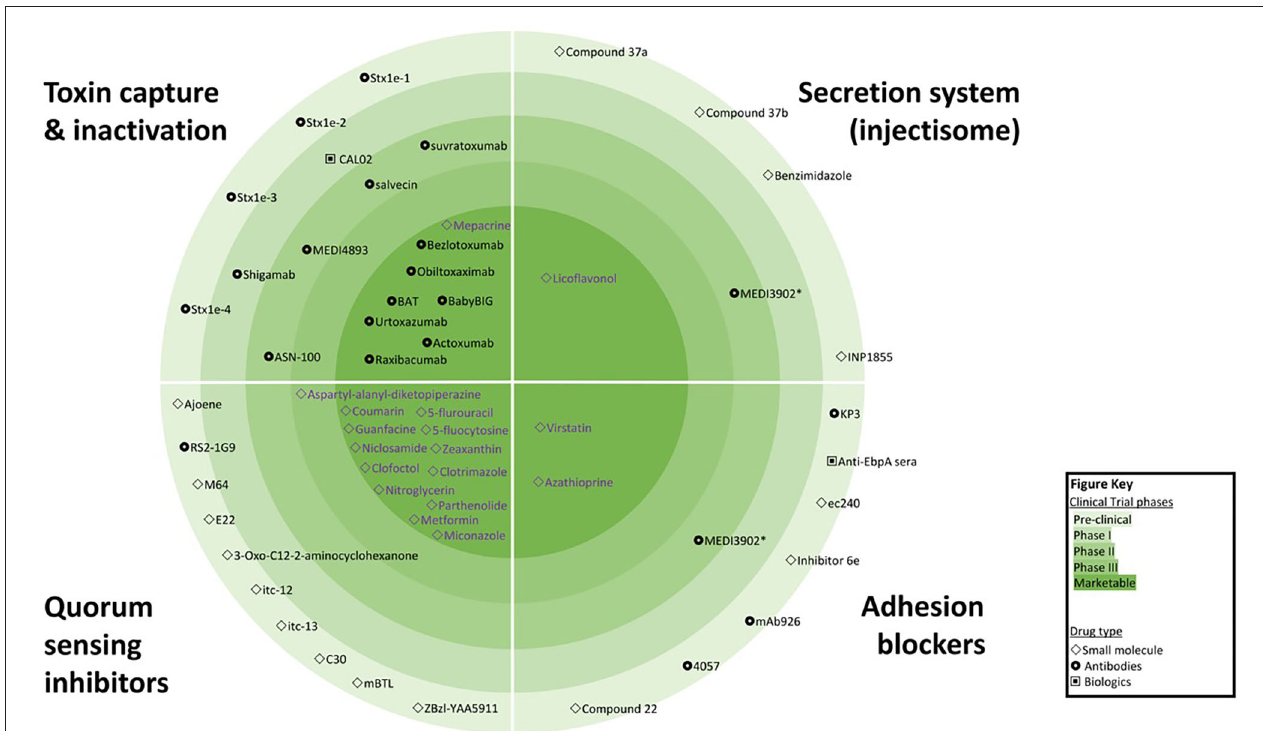
FIGURE 1 | Overview of the competitive landscape for virulence arresting drugs